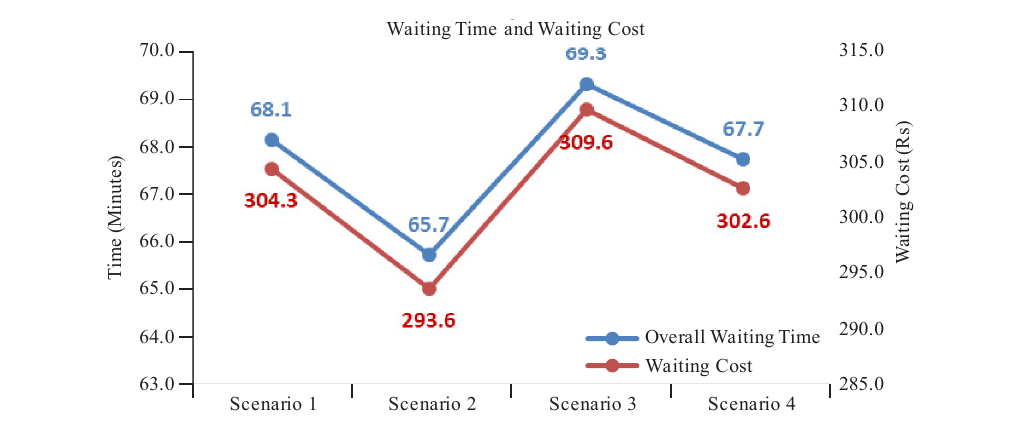
FIG. 13. PATIENTS‘ WAITING COST IN DIFFERENT